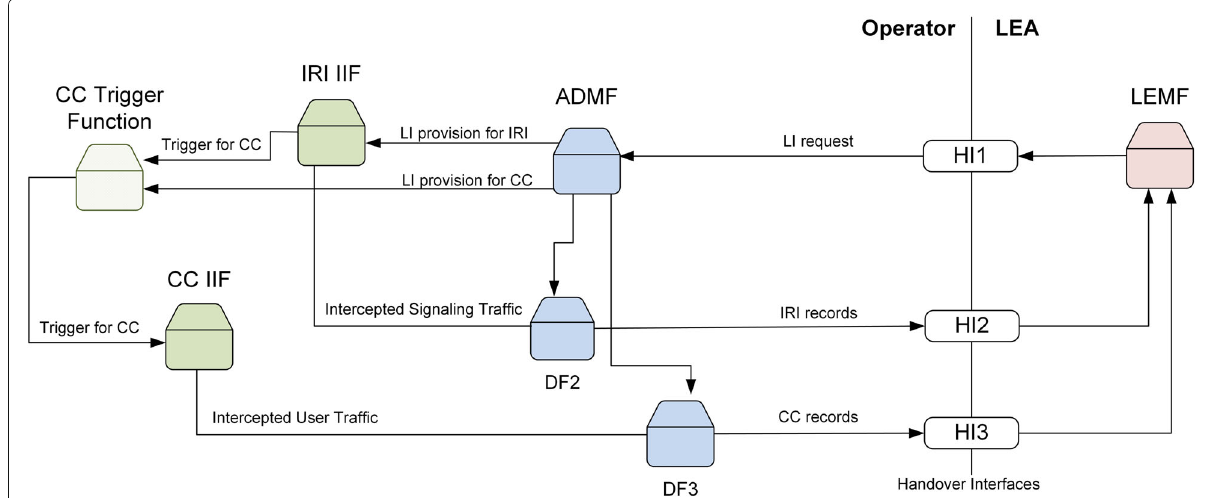
Fig. 10 LI adaptation for networks composed of VNFs. The CCTF is shown as a standalone function but can be implemented as part of the